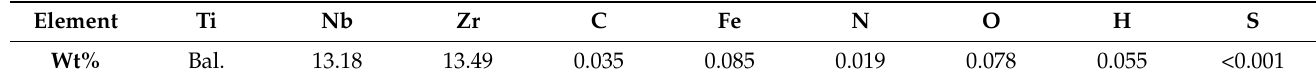
Table 1. Nominal composition of titanium alloy Ti-13Nb-13Zr [26].